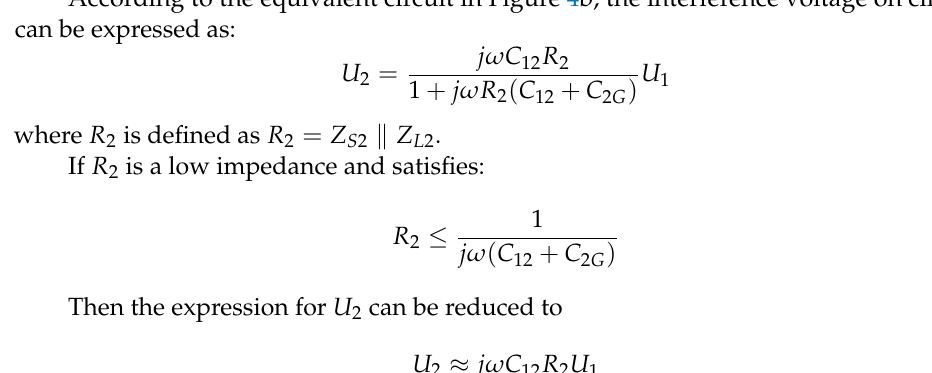
(shaded area shown in the figure). The experimental results are in high agreement with the qualitative electrical interference